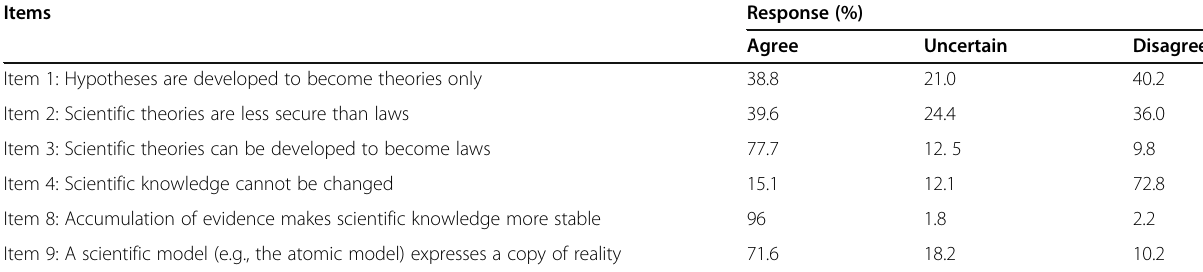
Table 3 Perceptions of the NOS: Scientific Knowledge ( N = 225) Items Response (%)